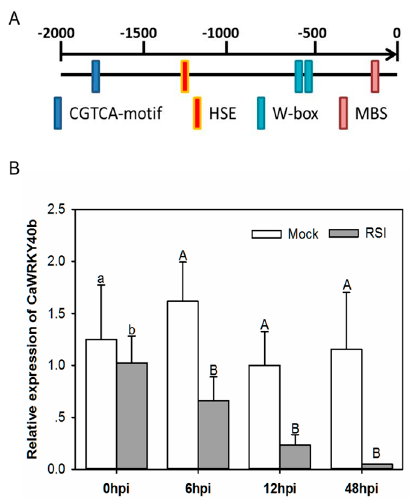
Figure 1. qRT-PCR analysis of relative CaWRKY40b transcript levels in Ralstonia solanacearum